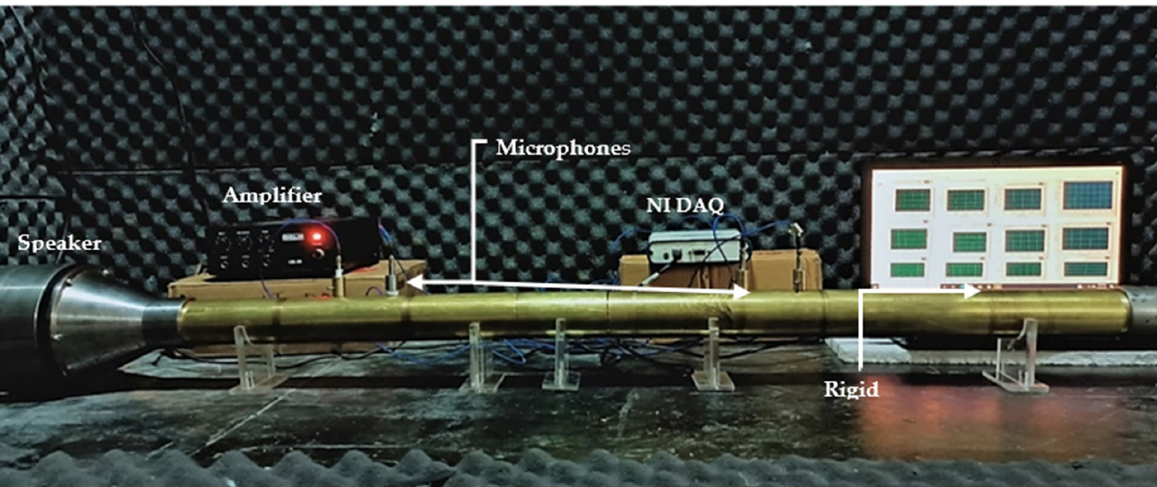
Figure 4. Four-microphone impedance tube configuration for acoustic properties measurements .